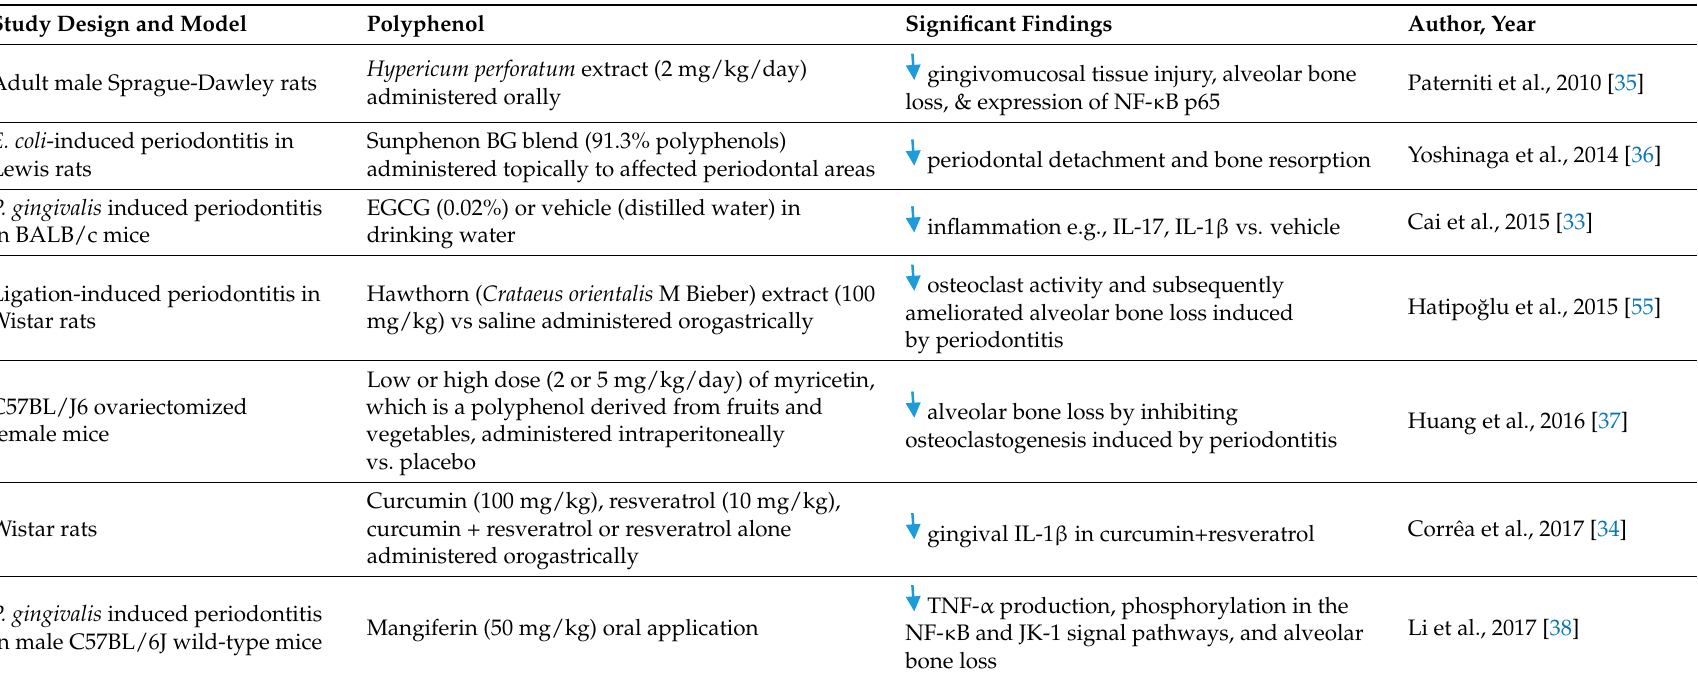
Table 3. Polyphenols as antioxidant/anti-inflammatory/antimicrobial agents in periodontitis: experimental animal models.